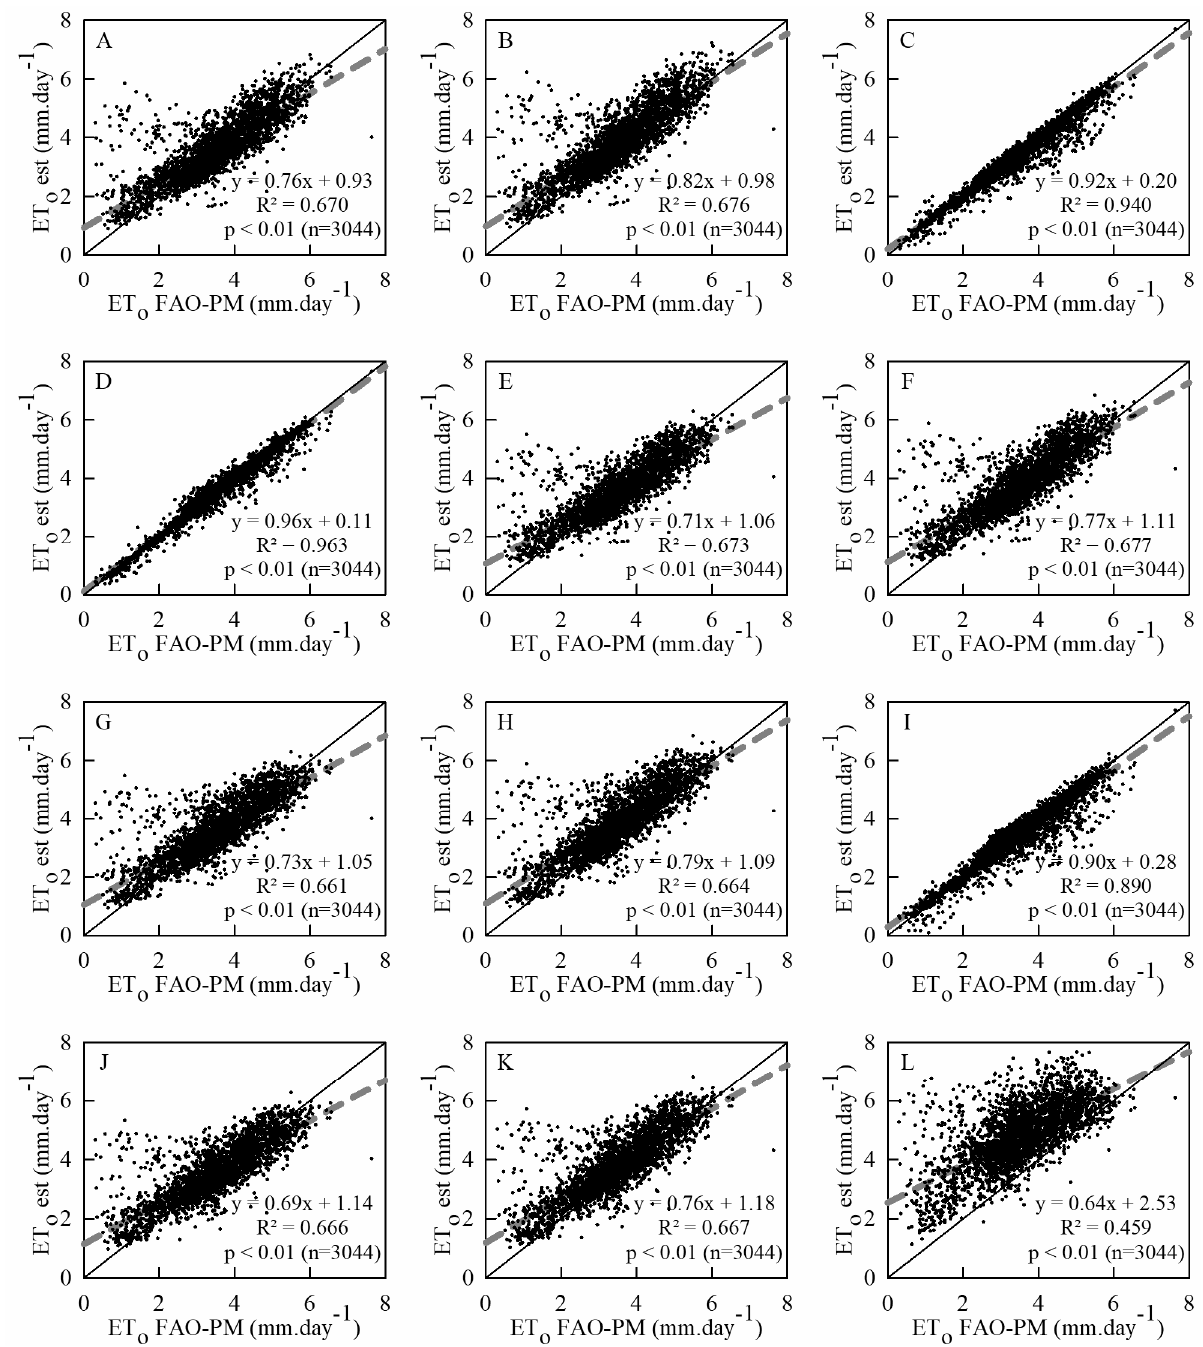
Figure 4. ET o values estimated using estimates of ( A ) Rs-a; ( B ) Rs-b; ( C ) RH; ( D ) WS; ( E ) Rs-a and RH; ( F ) Rs-b and RH; ( G ) Rs-a and WS; ( H ) Rs-b and WS; ( I ) RH and WS; J) Rs-a, RH, and WS; ( K ) Rs-b, RH, and WS; and ( L ) HS, in comparison with ET o estimated with full data set ( ET o FAO-PM). The central line represents a 1:1 correlation, and the dashed line represents the linear regression through the origin. Table 2. Comparison between ET o computed from full data set and estimates of ET o with missing climatic data.